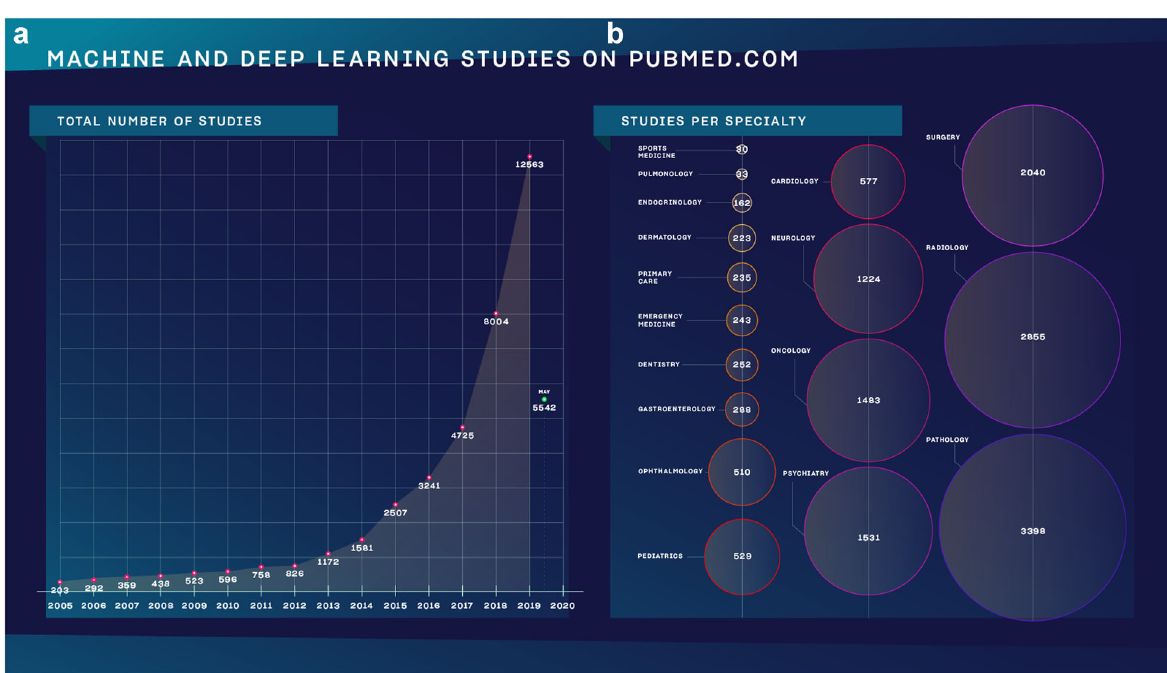
Fig. 1 Number of medical A.I. studies by year from 2010 to 2020; and by medical specialties. a The number of studies as found on Pubmed.com using the search term) “ machine learning ” OR “ deep learning ” ) and choosing a year in advanced search. b The same search method was used followed by (AND specialty) without specifying a time frame. The number in the circles determine how many studies we